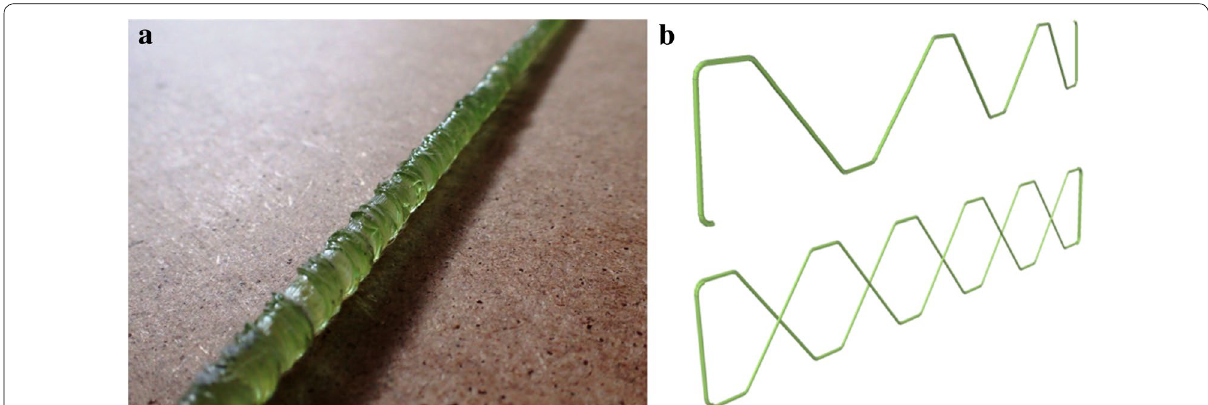
Fig. 3 Glass fibre reinforced polymer (GFRP) bar with helical ribs ( a ) and overview of single connector (upper) and double connector (lower) ( b ).